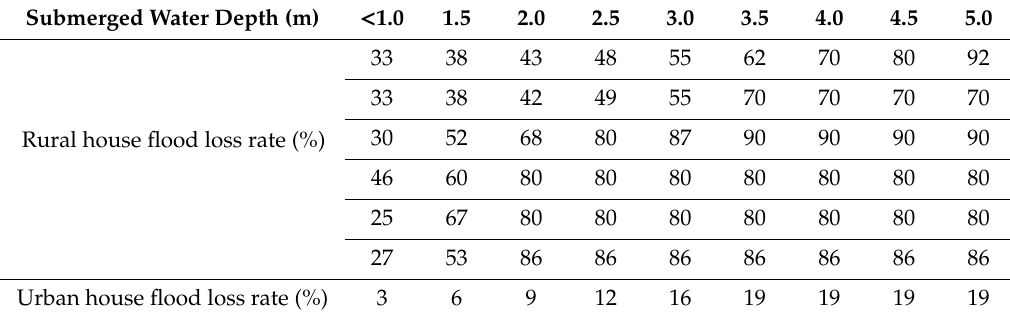
Table 2. Building flood loss rate statistics from the study area (early